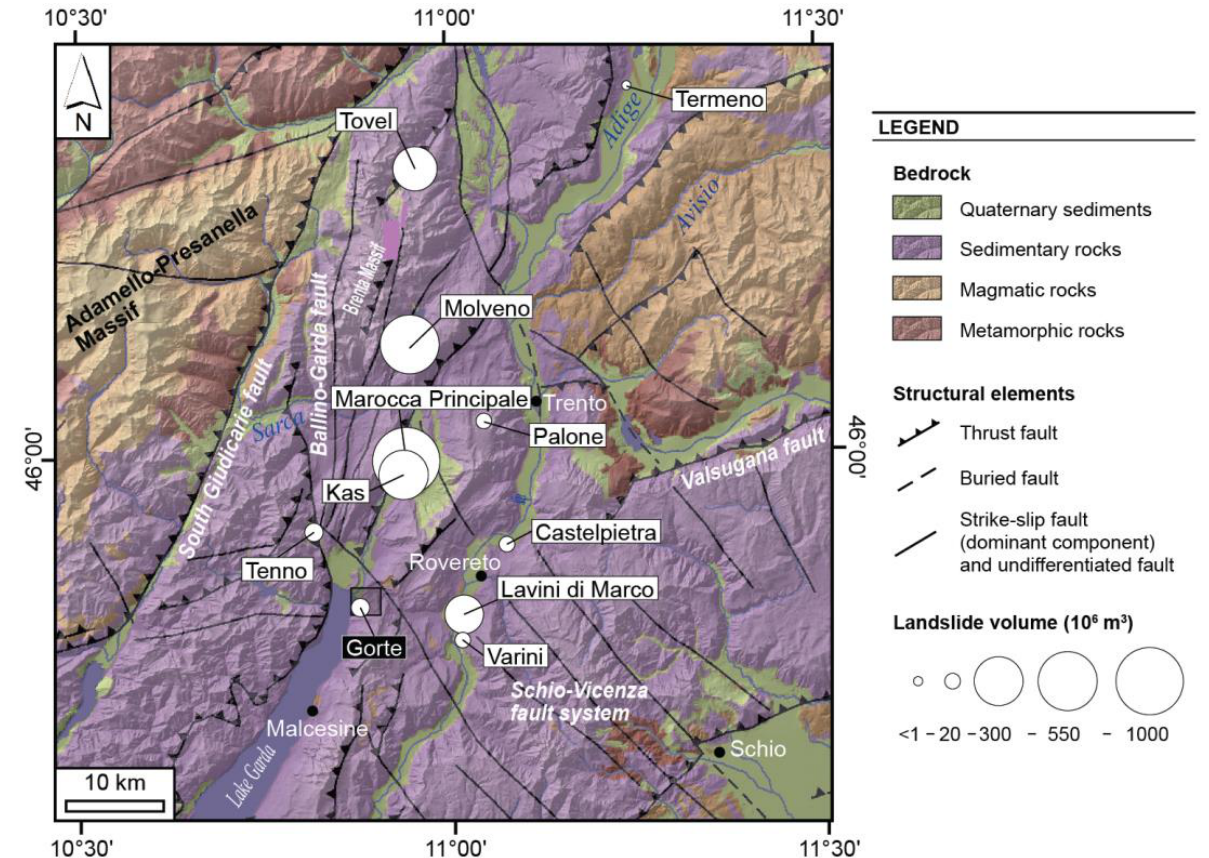
Figure 2. Simplified geological map of the Sarca and Adige Valleys (data from the Geological Survey of Trento, CARG project database) with the locations of the major landslides that have occurred in the area. Circle sizes are proportional to landslide volume (modified from [26]; Elsevier used with permission). The Tovel deposits are grouped in a single circle, despite the fact they are due to many events, with an estimated total volume of 300 Mm 3 [27]. The Gorte rock avalanche is marked in black. The gray square corresponds to the location of Figure 4.